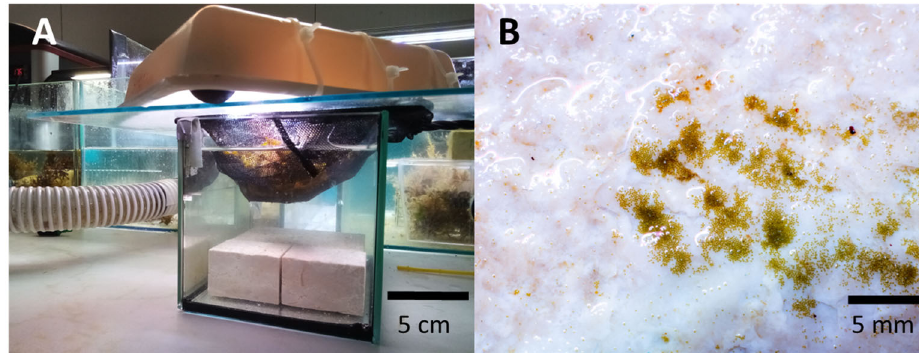
Figure 8. Seeding of Fucus virsoides onto limestone tiles ( A ) and early stage germlings ( B